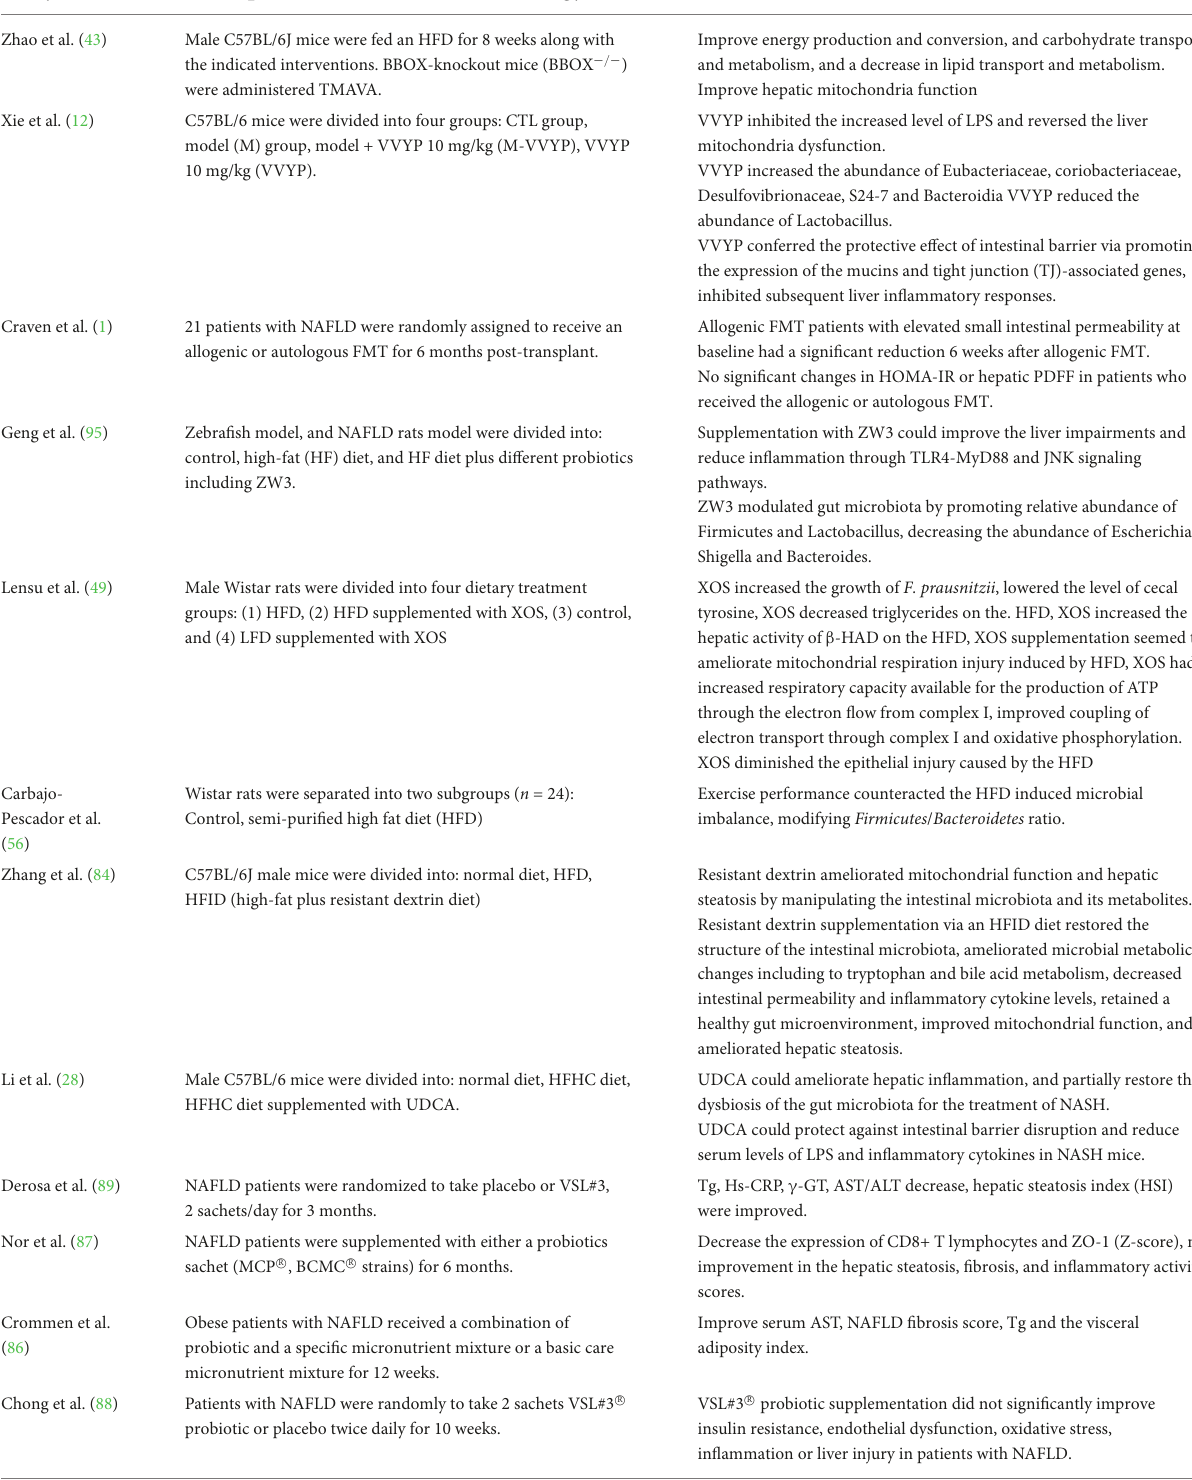
TABLE 3 Trials on the exploring of therapeutic strategy target to gut microbiota.